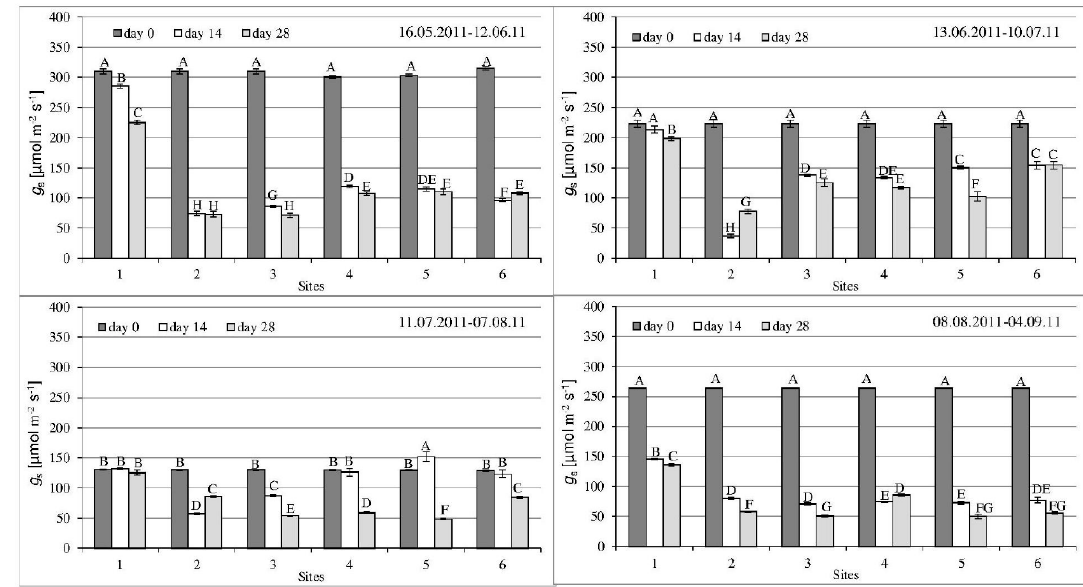
Figure 3. Stomatal conductance ( g s ) of L. multiflorum measured at control and exposure sites during four series. Vertical bars represent standard errors; different letters denote significance difference at level α ≤ 0.05 between all treatments within each series.